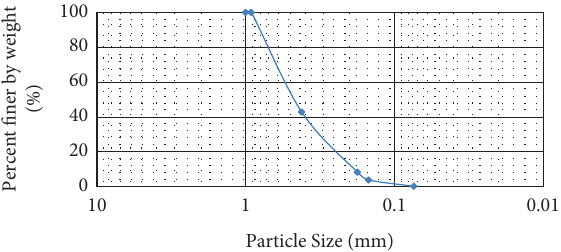
Figure 2: Grain size distribution of the